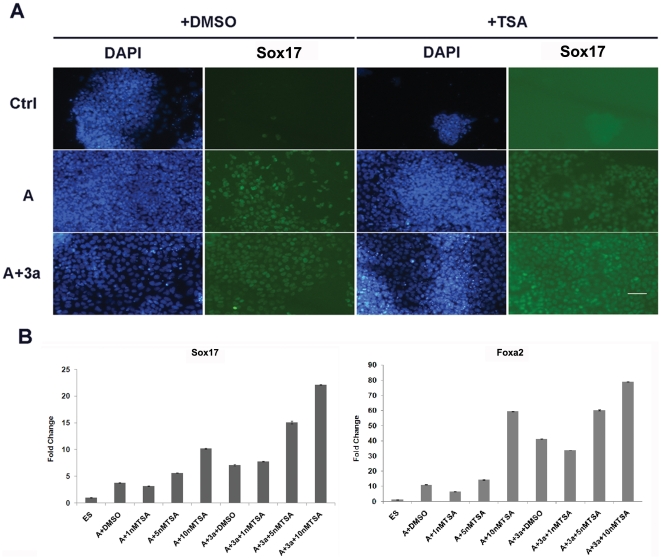
Inhibiting of histone de-acetylation by TSA.A. IF staining of Sox17 in control and 10 nM TSA treated differentiated samples. TSA was added at the final concentration of 10 nM to the differentiation medium for five days. DMSO was added as the negative control. Please note that addition of TSA greatly increases the DE differentiation efficiency. Scale bar: 50 uM. B. Sox17 and Foxa2 expression in cells treated with different doses of TSA was examined by RT-qPCR. Mouse ESCs were treated the same as above, TSA was added at the final concentration ranging from 1 nm to 10 nM to the differentiation medium for five days as indicated. Please note that TSA dose dependently increases the DE marker expression. Data are expressed as mean fold change ± SD. A: Activin A; 3a:Wnt3a.